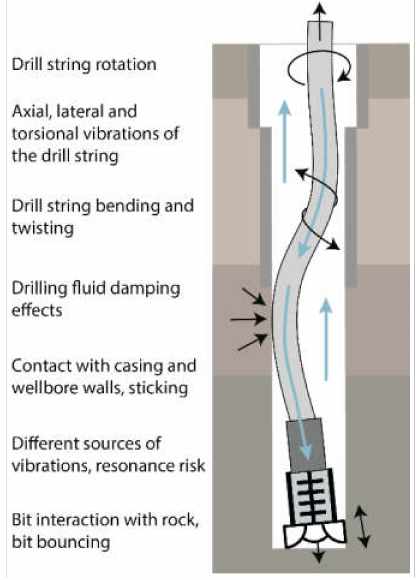
Figure 2. The drill string